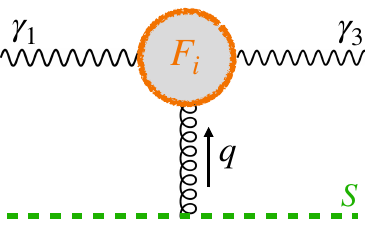
Figure 1 . Type of diagram contributing to the eikonal scattering and the resulting time delay via the form factors F i . Curly lines are graviton legs, wiggle lines represent photons, dashed lines are the spectators, and F i are the form factors defined in eq. (1.3) associated to the photon energy-momentum